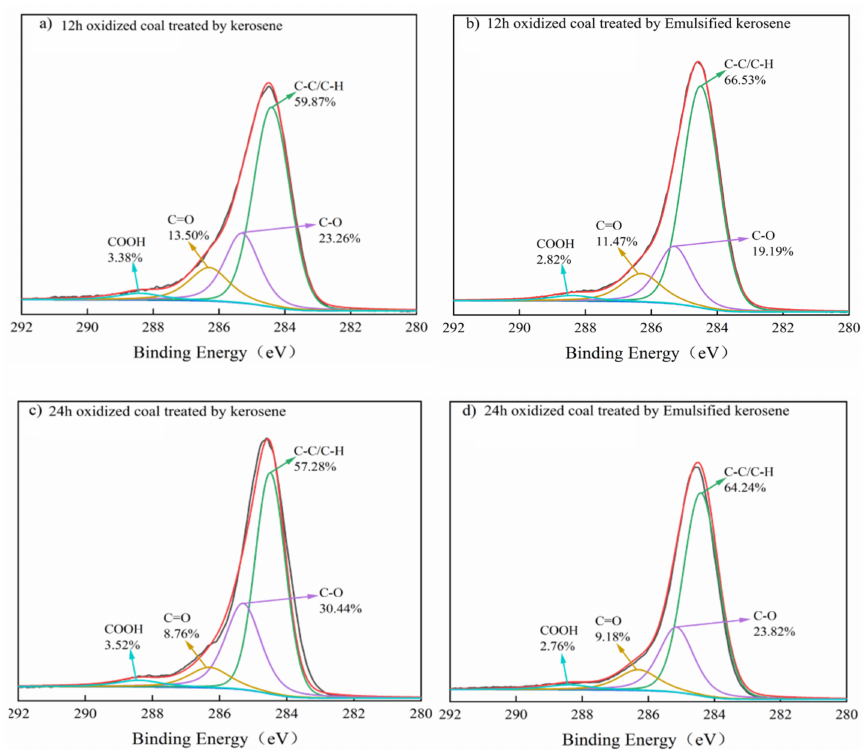
Figure 12. Fitted XPS C1s spectra of coal with different oxidation degrees treated by kerosene and emulsified kerosene. For conventional conditions (only kerosene), the collector and dosage were 500 g/t kerosene. For the mixture reagent (emulsified kerosene), the equivalent kerosene dosage was also kept as 500 g/t as a control test. Black line: the original data of XPS test. Red line: the data fittied by XPSPEAK 4.1